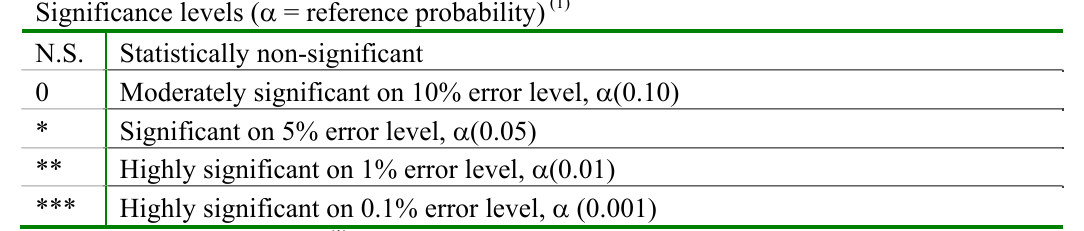
Table 8. Statistical significance levels.